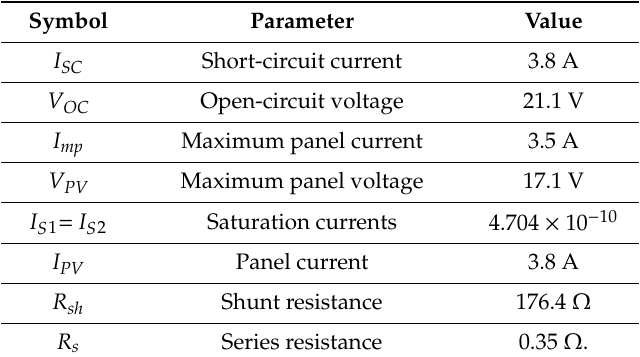
Table 1. Parameters of PV Array [37].